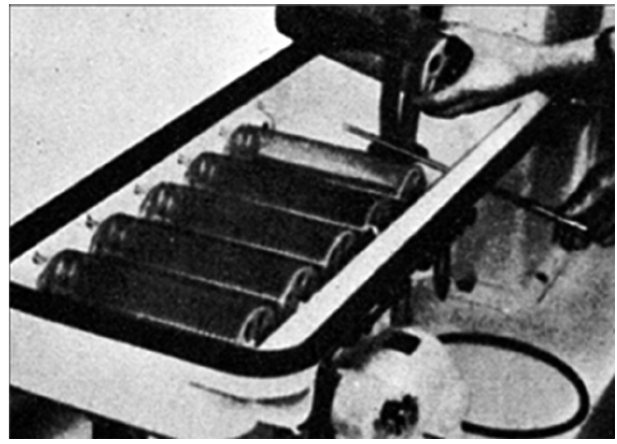
Fig. 1 - Cylinder (drum) oxygenator, 1957. Source: Correa Neto, 1988.